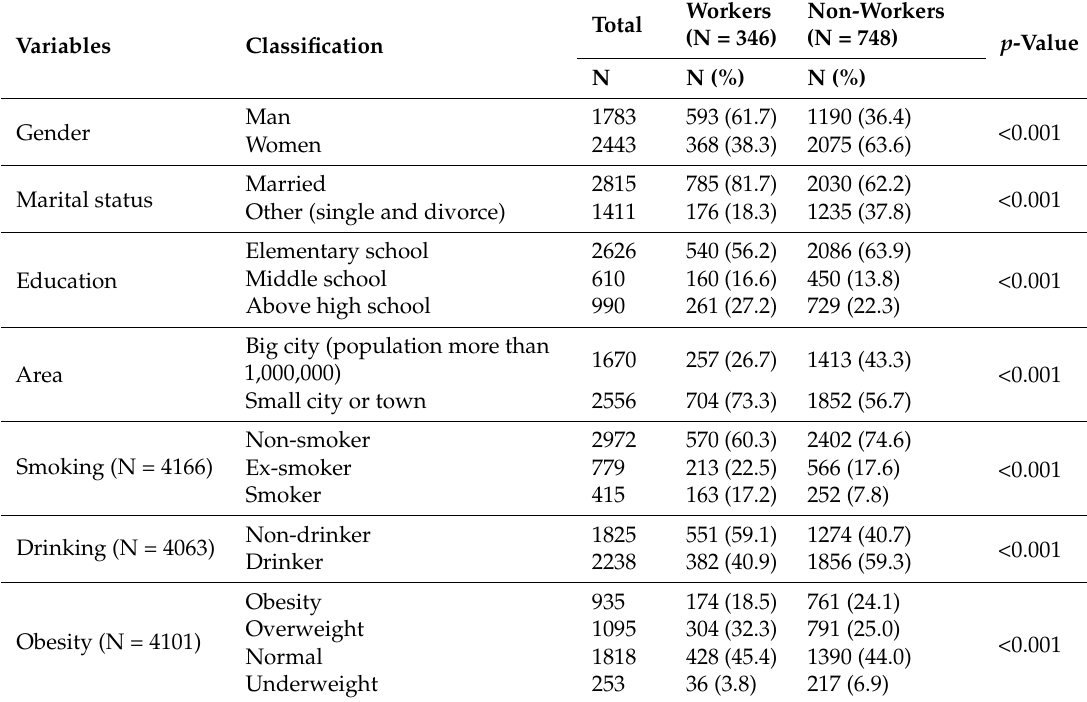
Table 1. The demographic characteristics and health behavior of the